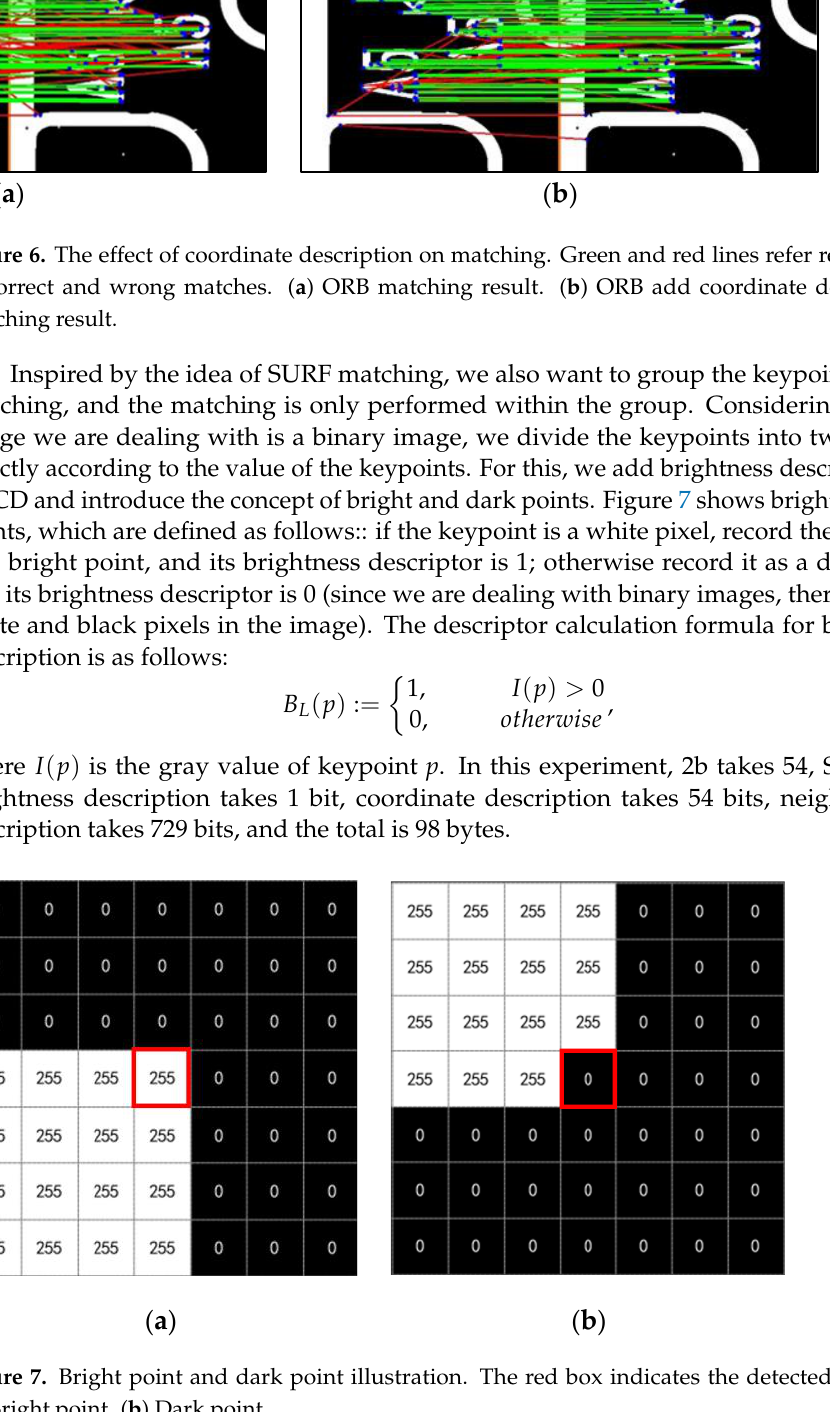
Figure 6. The effect of coordinate description on matching. Green and red lines refer respectively to correct and wrong matches. ( a ) ORB matching result. ( b ) ORB add coordinate descriptions matching result.